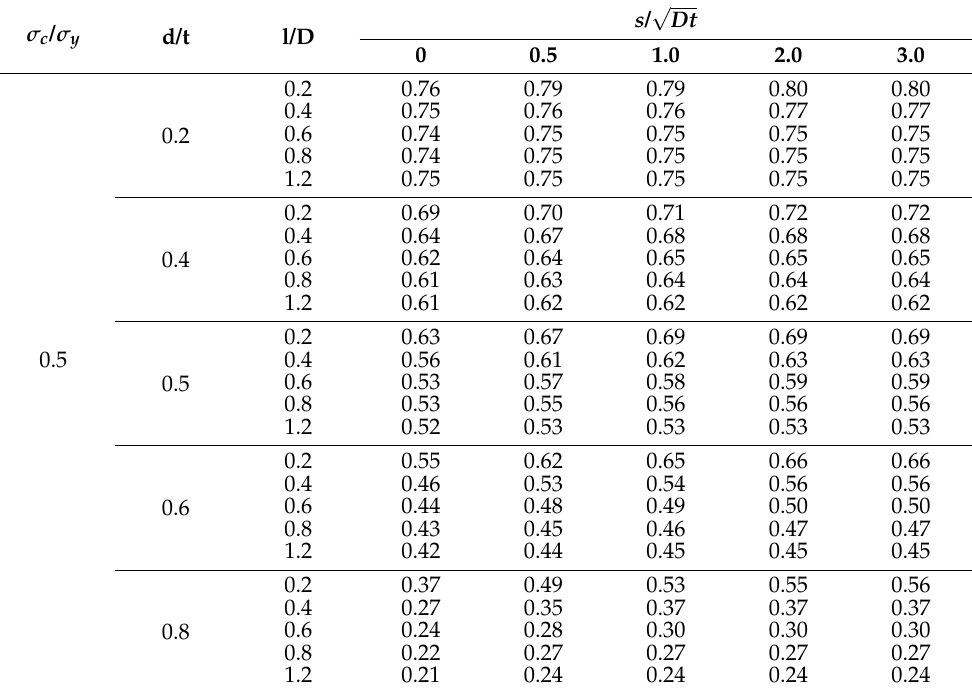
Table 8. FEA on corroded pipeline with LID subjected to internal pressure and 0.5 σ c / σ y longitudinal compressive stress.